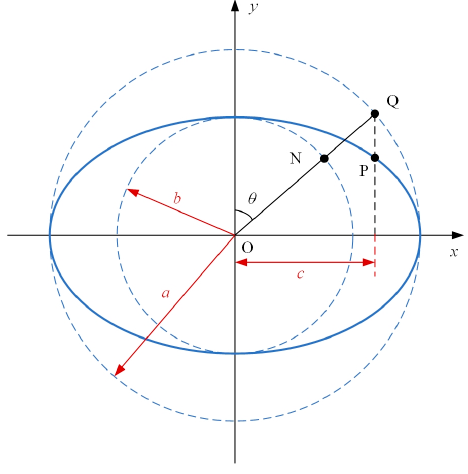
Figure 2. The eccentric angle of the ellipse.